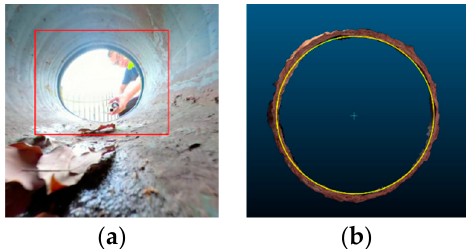
Figure 13. Panorama stitching error in scene 2 ( a ), and the circle fitting effect in scene 1 ( b ).